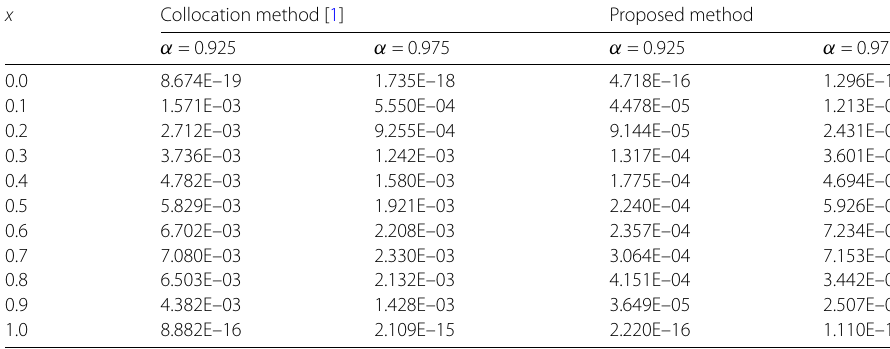
Table 9 The L ∞ -norm and L 2 -norm with h = 10 τ = 1 M L ∞ -norm L 2 -norm Order of convergence CPU